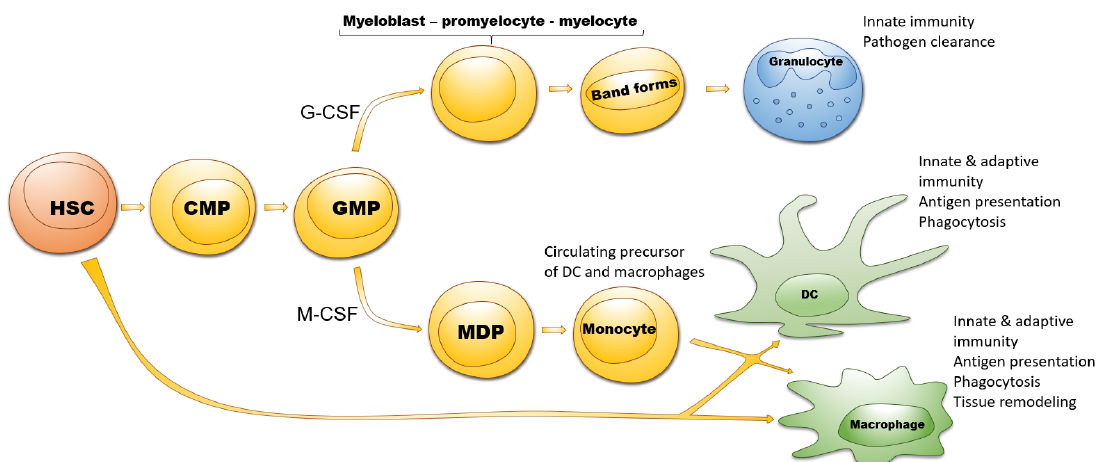
Figure 1. Differentiation of myeloid cells. Hematopoietic stem cells (HSC) differentiate into the common myeloid progenitors (CMP) and further into the granulocyte-macrophage progenitors (GMP). The granulocyte colony-stimulating factor (G-CSF) generates the differentiation of GMP via myeloblasts, promyeloblasts, myelocytes, and band forms into granulocytes (shown by the arrows), whereas macrophage colony-stimulating factor (M-CSF) induces GMP development towards monocytes, macrophages or DC via monocyte/macrophage and dendritic cell progenitors (MDP) (shown by the arrows).